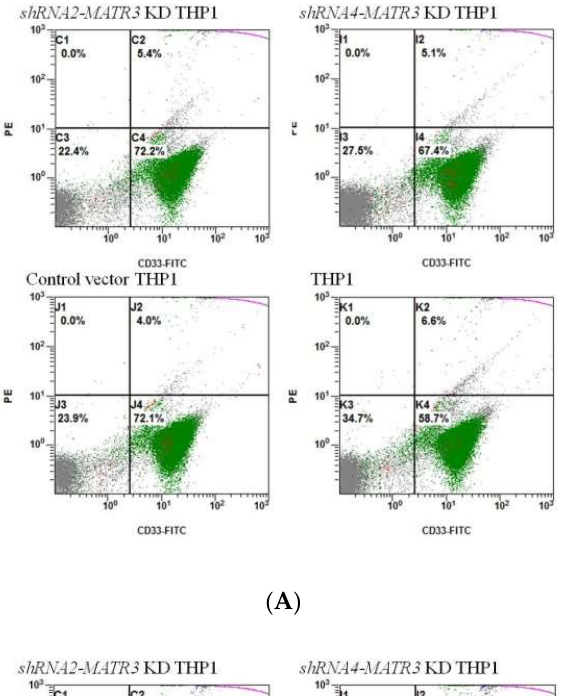
microscope analysis (Figure 4, Supplementary Figures S1 and S2).